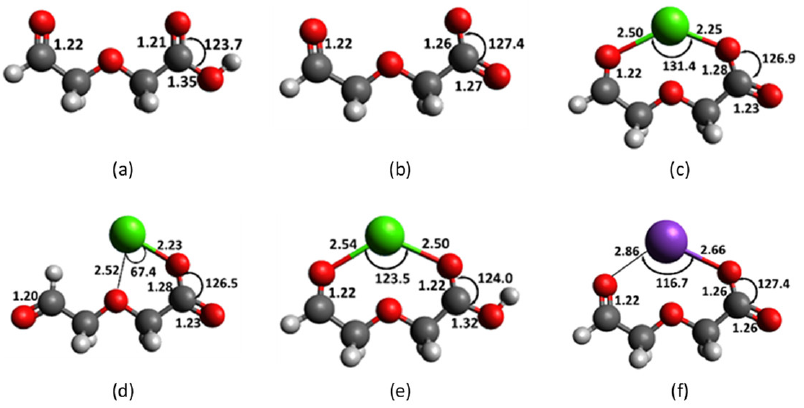
Figure 5. Optimized geometries of 4 and 4a in methanol; ( a ) 4 , ( b ) 4a , ( c ) complex of 4a and Ca 2+ , ( d ) complex of 4a and Ca 2+ with 2 oxygens, ( e ) complex of 4 and Ca 2+ , and ( f ) complex of 4a and K +